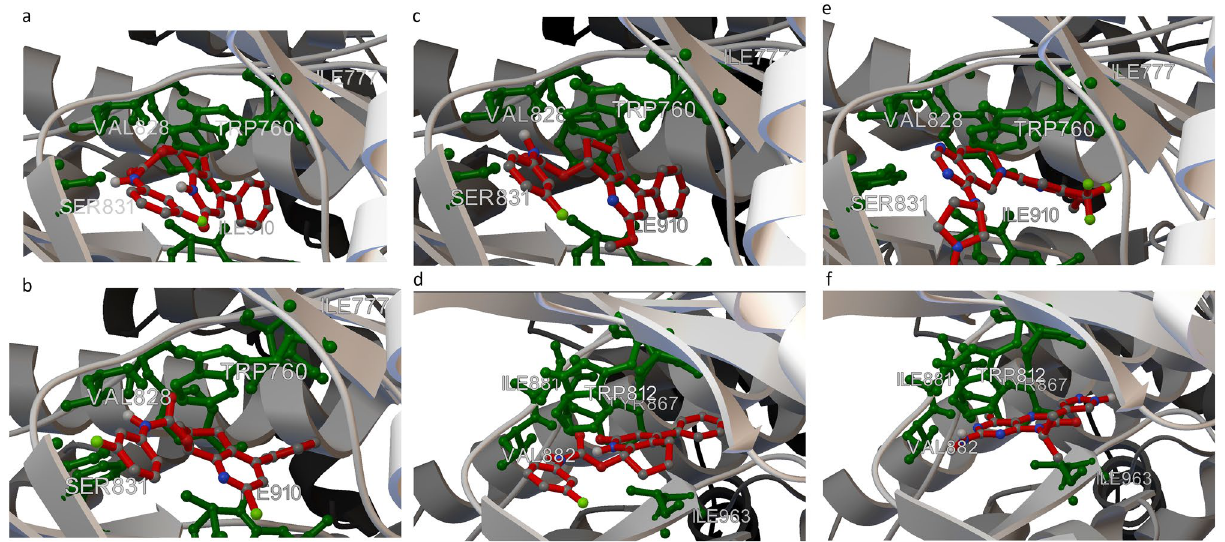
Figure 3. Results of molecular docking. ( a ) Binding mode of (R)- 20d to PI3K δ. ( b ) Binding mode of (S)- 18d to PI3K δ. ( c ) Binding mode of (R)- 19d to PI3K δ. ( d ) Binding mode of (S)- 20d to PI3K γ. ( e ) Binding mode of Leniolisib to PI3K δ. ( f ) Binding mode of 2-amino-4-methyl-8-(1-methylethyl)-6-(1H-pyrazol-4-yl)pteridin- 7(8H)-one to PI3K